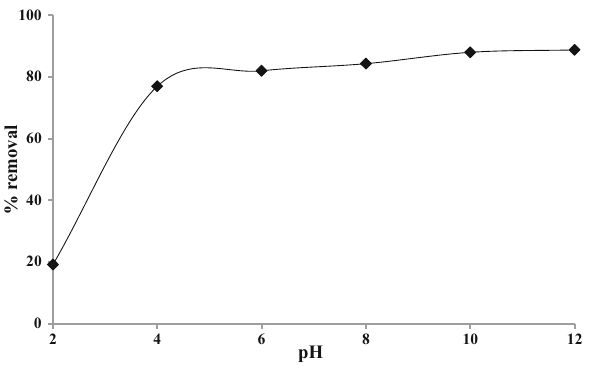
Fig. 6 Effect of the initial MB concentration and contact time on the removal of MB. C-ZMN: 0.8 g L - 1 ; temperature: 298 K